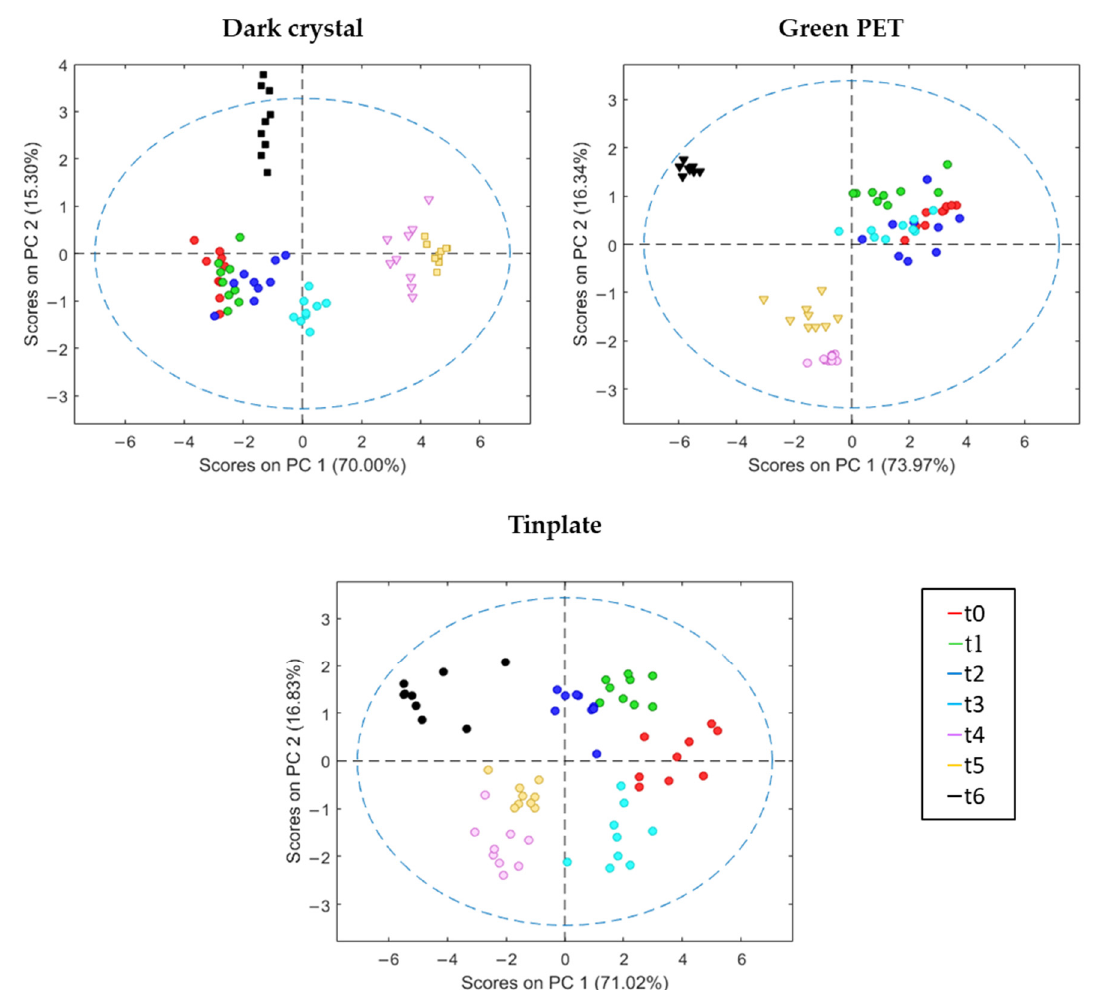
Figure 4. Score plot of the PCA analysis for oils stored in different containers. Dot: extra virgin olive oil; triangle: virgin olive oil; square: lampante olive oil. oil; triangle: virgin olive oil; square: lampante olive